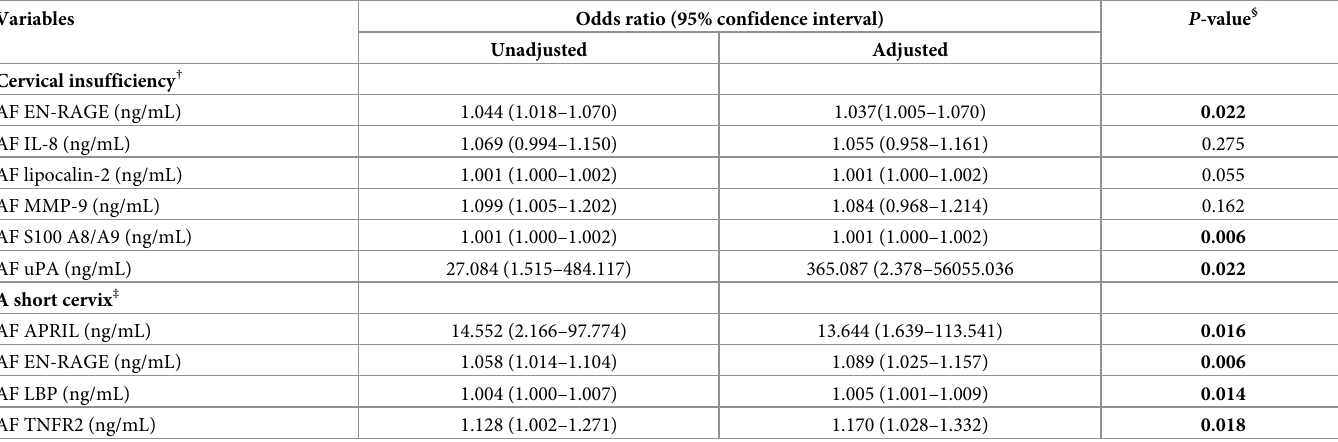
Table 3. Multivariable logistic regression model showing the unadjusted and adjusted odds ratios of an association between various proteins in amniotic fluid and spontaneous preterm birth at < 32 weeks in women with cervical insufficiency and a short cervix.